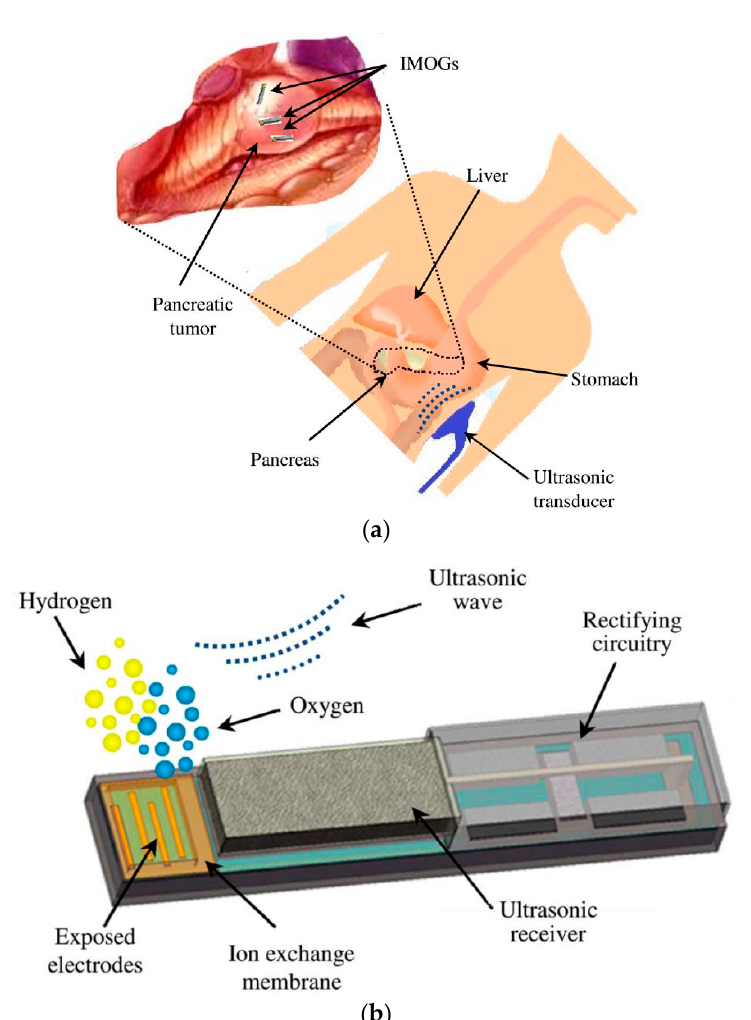
Figure 44. Proposed implantable micro-oxygen generator (IMOG) device [206]. ( a ) Conceptual view of IMOG implanted in a pancreatic tumor. ( b ) Various components in a complete IMOG including ultrasonic power RX. Copyright © 2011, IEEE. Sensors 2020 , 20 , x FOR PEER REVIEW